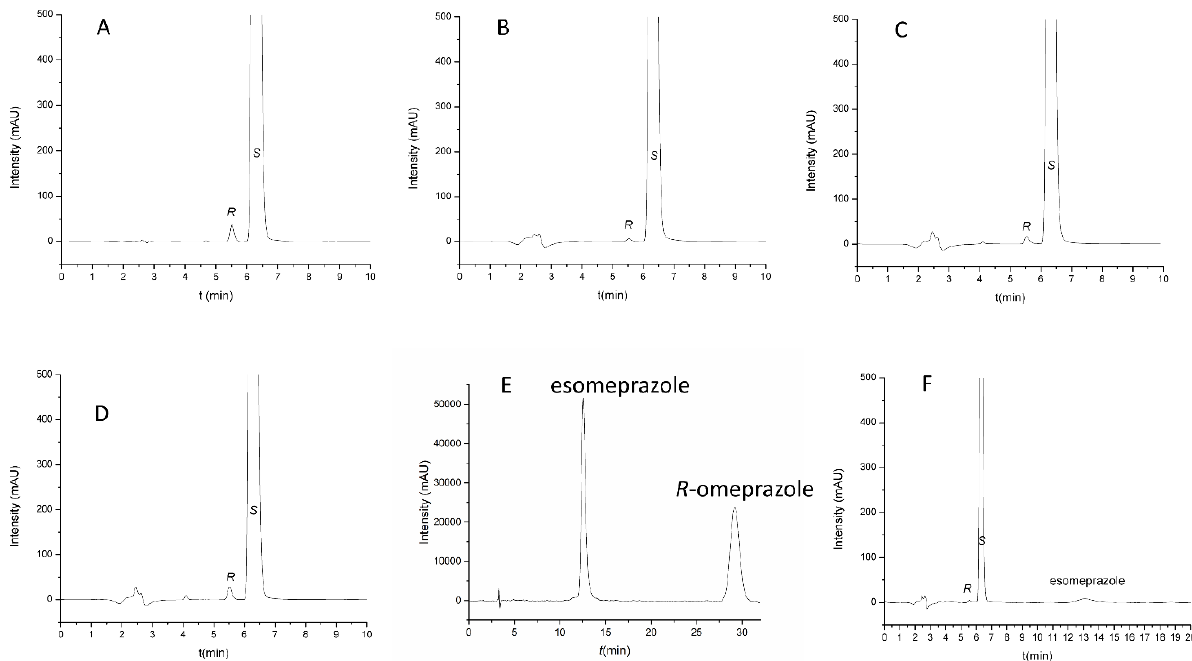
Figure 6. Representative chromatograms obtained during method application. ( A ) Naproxen sample spiked with 0.1% enantiomeric impurity; ( B ) Aleve, film-coated tablets; ( C ) Apranax, film-coated tablets; ( D ) Apranax Dolo gel; ( E ) Racemic omeprazole sample; ( F ) Vimovo delayed-release combina- tion tablets. Chromatographic conditions: Lux Amylose-1 column, thermostated at 40 ◦ C. Mobile phase: MeOH:water:acetic acid 85:15:0.1 ( v / v / v ). Flow rate 0.65